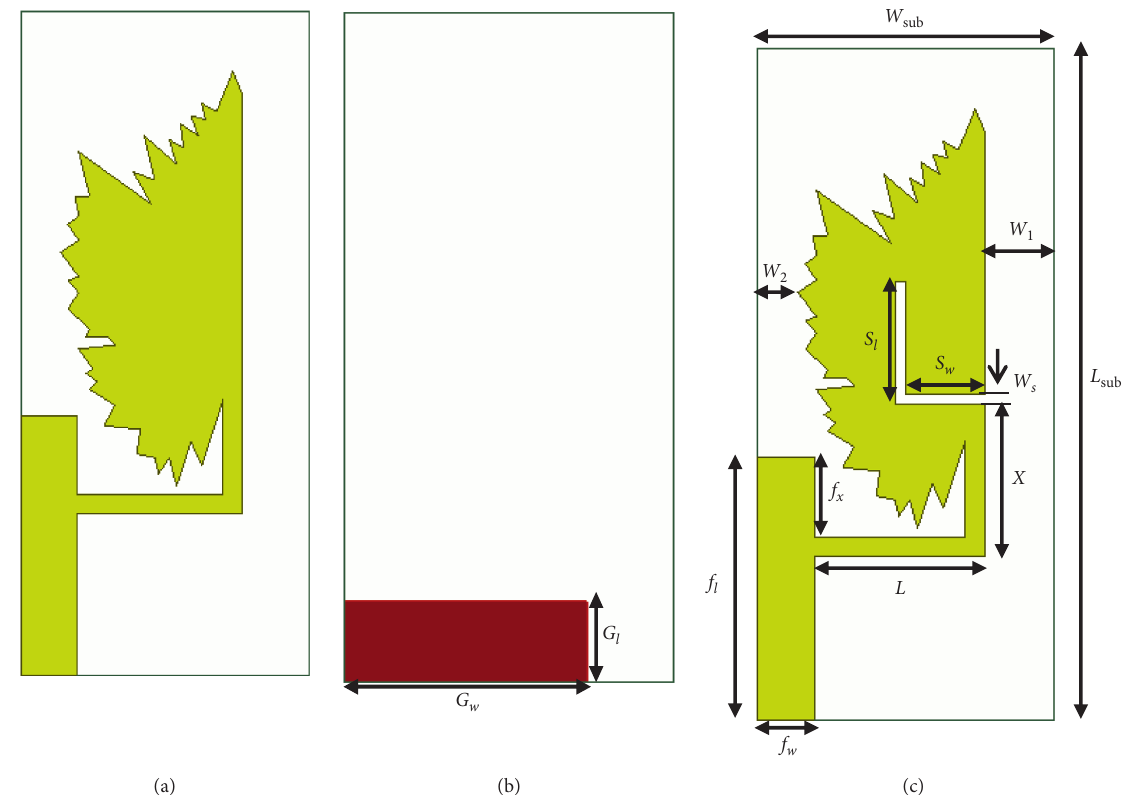
Figure 3: Top-view of the proposed Deliciosa-leaf based configurations. (a) Slitless patch. (b) Defected-width ground plane, (c) L-slitted patch